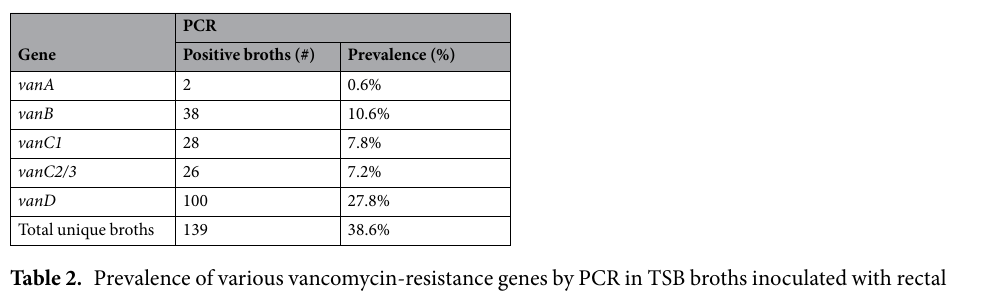
Table 2. Prevalence of various vancomycin-resistance genes by PCR in TSB broths inoculated with rectal swabs. 360 rectal swabs were used to inoculate TSB broths. The broths were left to incubate at 37 °C overnight prior to analysis by